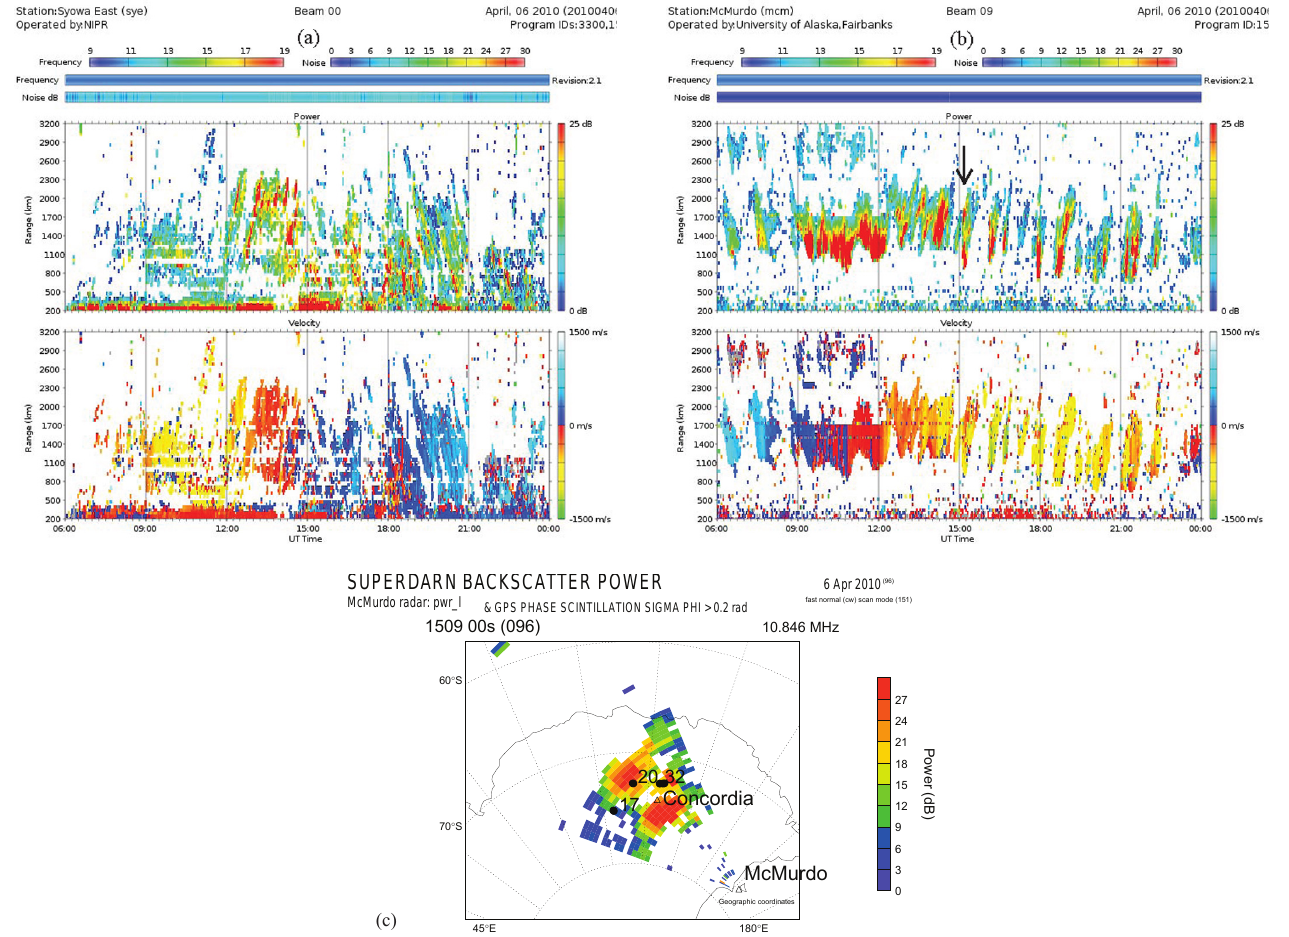
Fig. 12. The (a) Syowa East and (b) McMurdo radar backscatter power and LOS velocity showing a long series of polar cap patches. The arrow in panel (b) points to time 15:09UT of (c) one scan showing McMurdo radar backscatter power and superposed GPS ionospheric pierce points at altitude 350km when phase scintillation index σ 8 exceeded 0.2